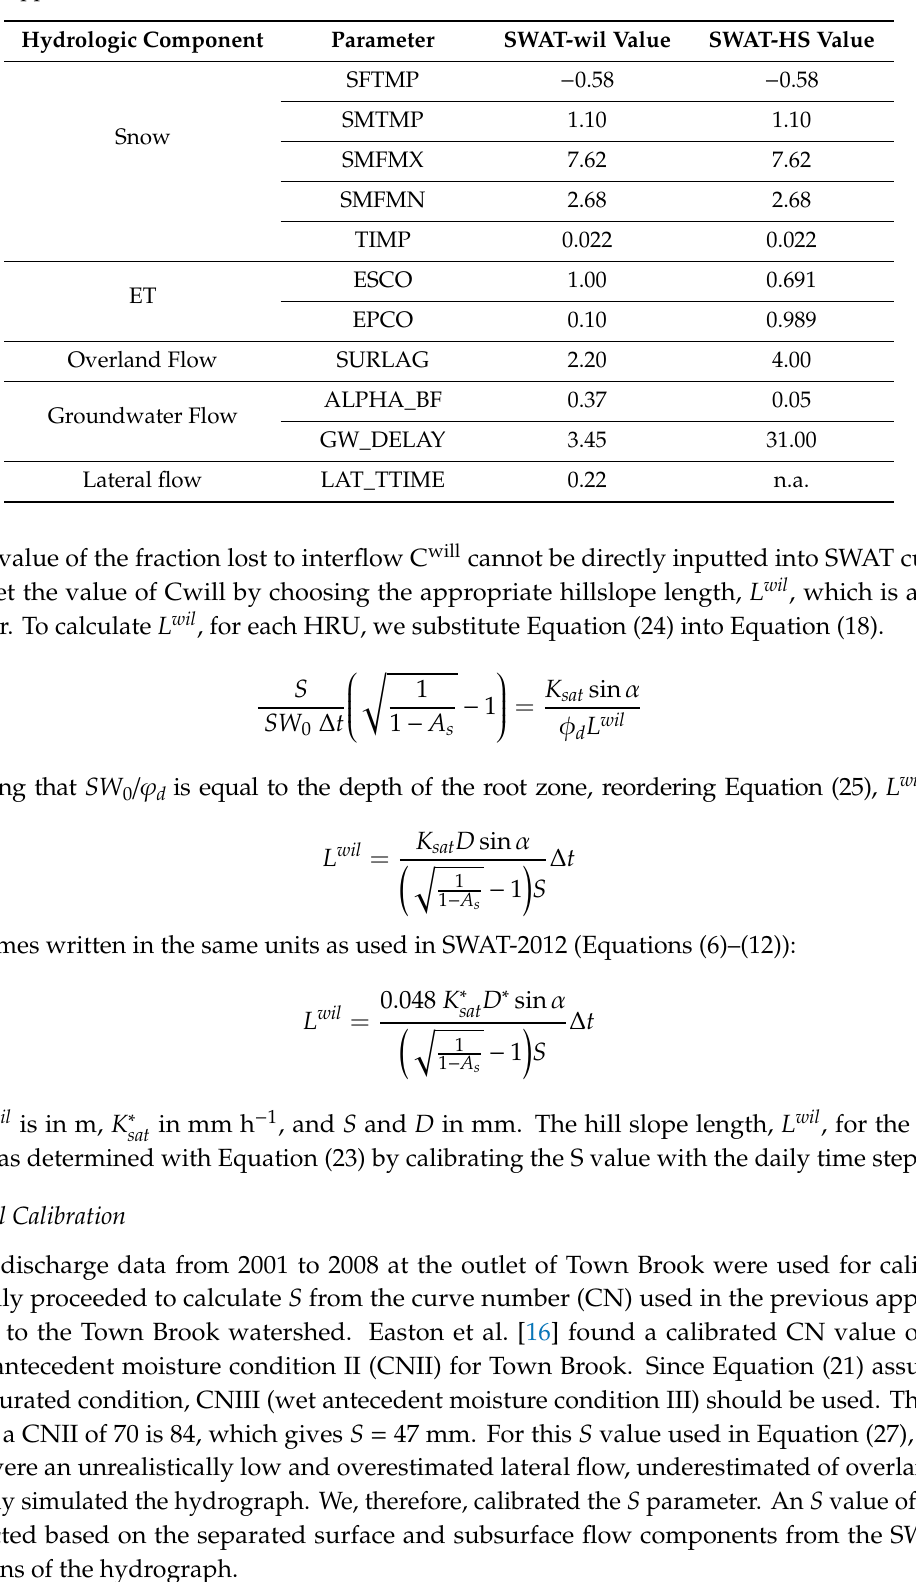
Table 2. Basin level parameters for SWAT-wil and SWAT-HS model applications for Town Brook; n.a. is not applicable because the lateral flow was calculated in the SWAT-HS